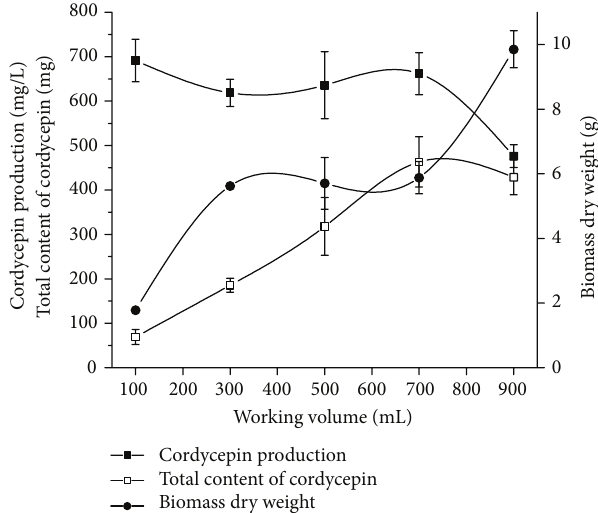
Figure 1: Effects of working volume on the production of cordy- cepin, total production of cordycepin, and biomass dry weight (total content ofcordycepin (mg) = cordycepin production (mg/L) × working volume